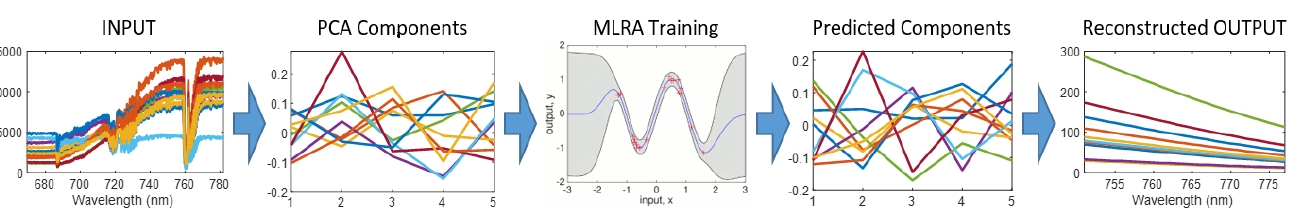
Figure 1. Diagram of the dimensionality reduction and reconstruction processing steps of the